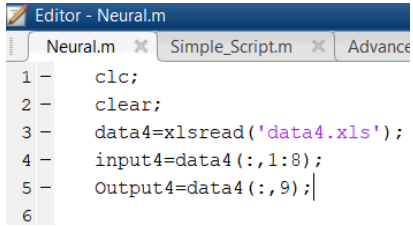
Figure 2. Xlsread function.